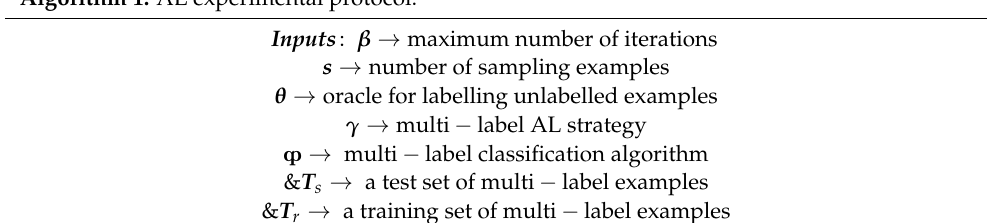
Algorithm 1. AL experimental